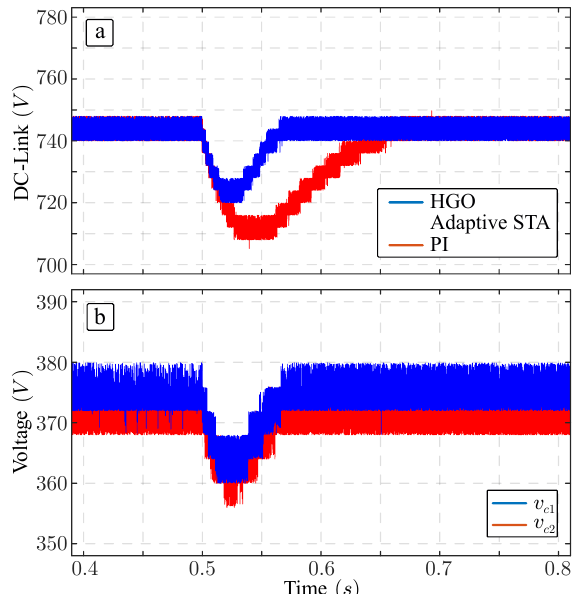
Figure 8. NPC drop voltage in the dc side under a 150 Ω load step. ( a ) DC-link voltage; ( b ) Two capacitor voltages with the proposed HGO-Adaptive STA strategy.